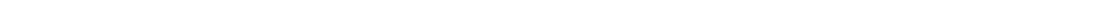
Fig. 13. Palaeospongilla chubutensis Ott and Volkheimer, 1972, Spongillida: Palaeospongillidae; and Spongilla patagonica Volkmer-Ribeiro and Reitner, 1991, Spongillida: Spongillidae; Aptian, Lower Cretaceous, 16 km NNW of Cerro Condor, Patagonia Chubut River Valley, Argentina. Spicules, skeleton architecture and gemmules, paratype MABA 24748. A . Drawings of megascleres (a), gemmuloscleres (b), and microscleres (c). B . Possible transversal section of several gemmules. C . Skeleton multispicular fibres or gemmular cage. D . Megascleres and microscleres. E . Naked gemmules. F . Armed gem- mule with radial gemmuloscleres and multispicular main fibre. G . Close up on the gemmular theca. H . Gemmule. I . Megascleres (a, b), microscleres of different dimensional classes (c, d). J . Gemmuloscleres. A–D, modified from Ott and Wolkheimer (1972), E–G, modified from Volkmer-Ribeiro and Reitner (1991b), H–J, modified from Racek and Harrison (1975).